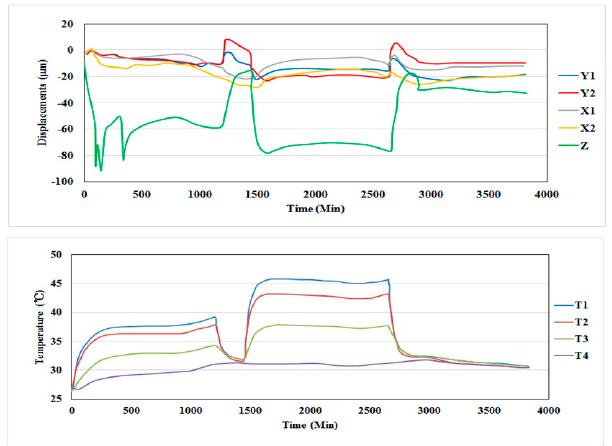
Figure 11. Temperature and displacement variations of the working table on the x ‐ and y ‐ axes and the spindle nose on the z ‐ axis during the 400 h operations. spindle nose on the z -axis during the 400 h